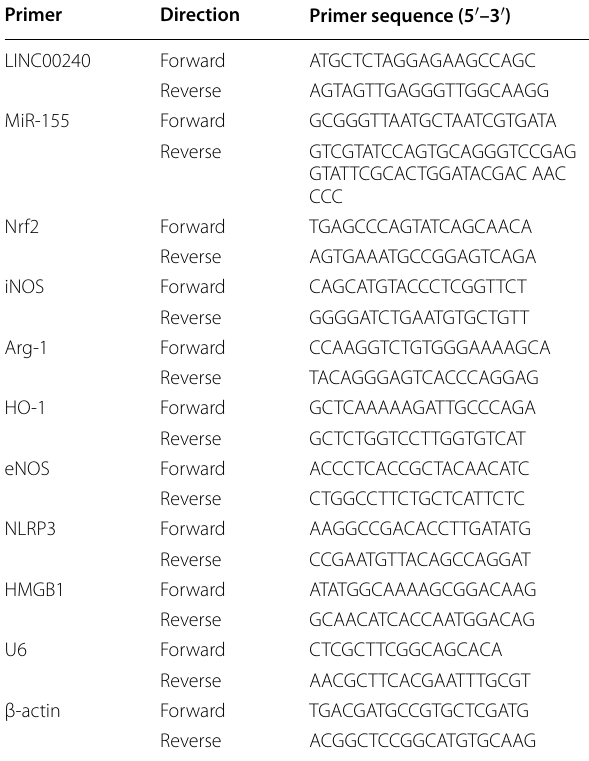
Table 2 Primers used for qRT‑PCR Primer